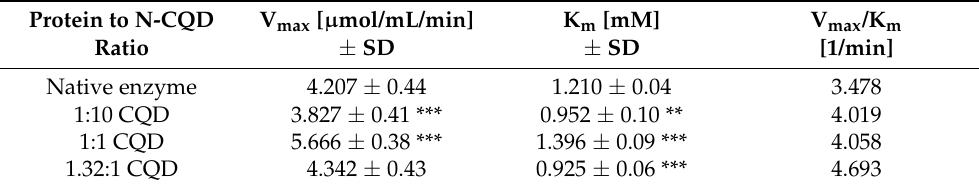
Table 4. Kinetic parameters of native and immobilized apyrase. The statistical significance of the differences between native and immobilized enzyme is marked with asterisks (** for p ≤ 0.01, *** for p ≤ 0.001).